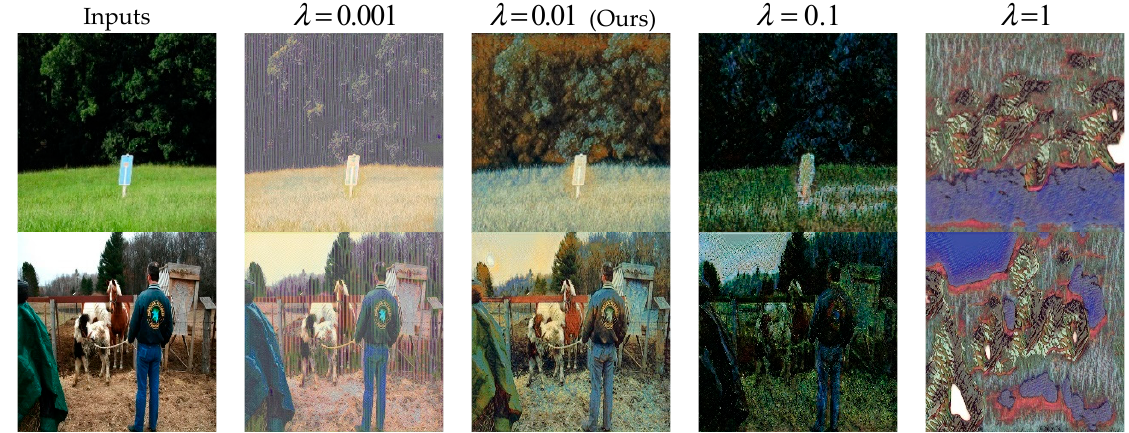
} { . Figure 14. Qualitative comparison of parameter λ = { 0.001, 0.01, 0.1, 1 }